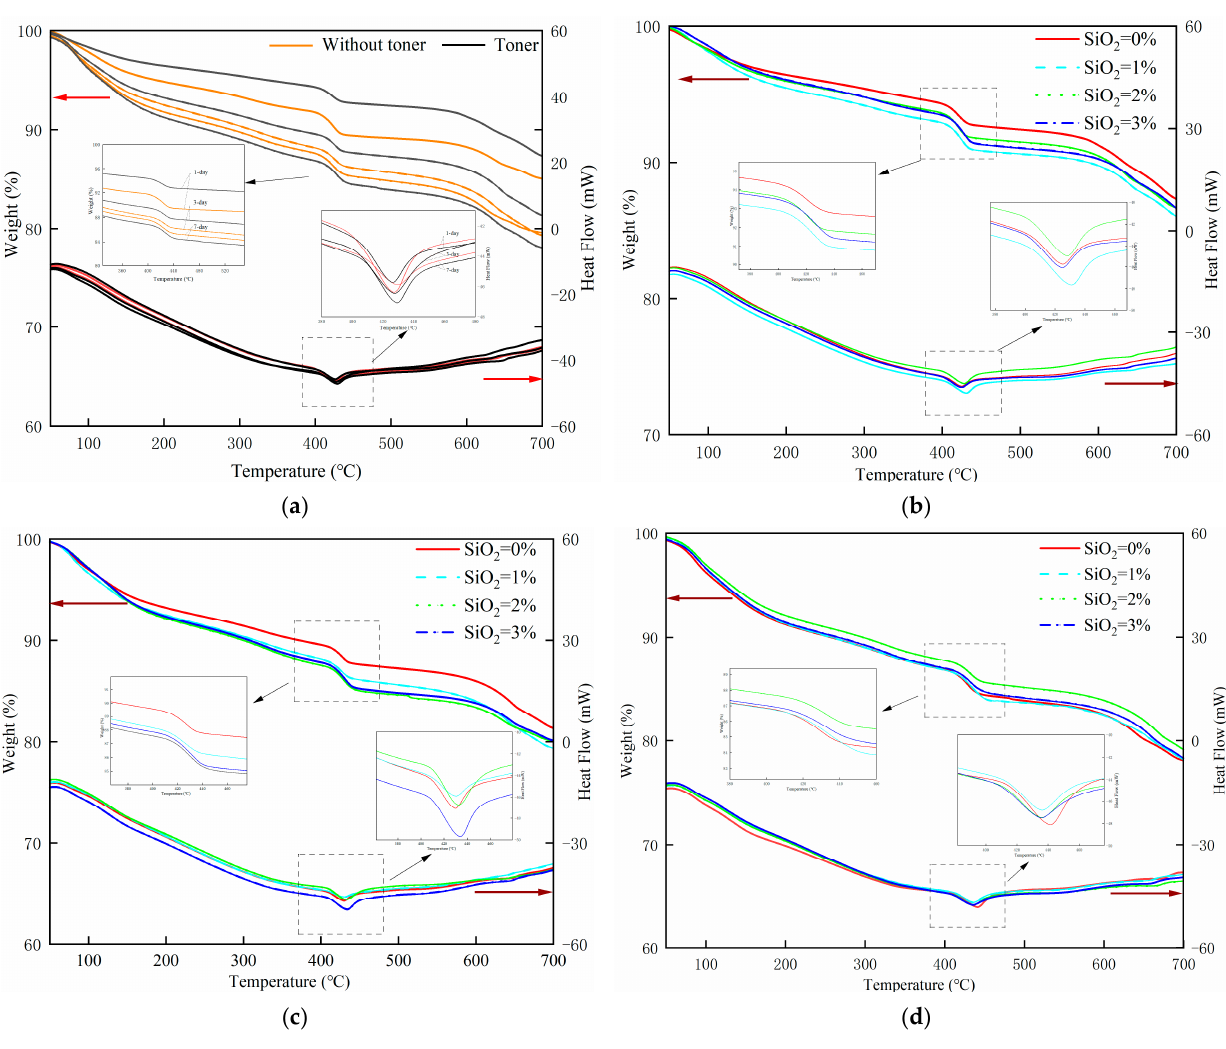
Figure 7. TG-DSC curves of the samples with the different curing ages: ( a ) cement grouting materials without the N-S, ( b ) CRTS at 1-day, ( c ) CRTS at 3-day, and ( d ) CRTS at 7-day. As shown in Table 5, the mass loss and enthalpy change of the CRTS have two obvious stages with different curing days and N-S contents. The N0 represents cement grouting materials without toner, and the